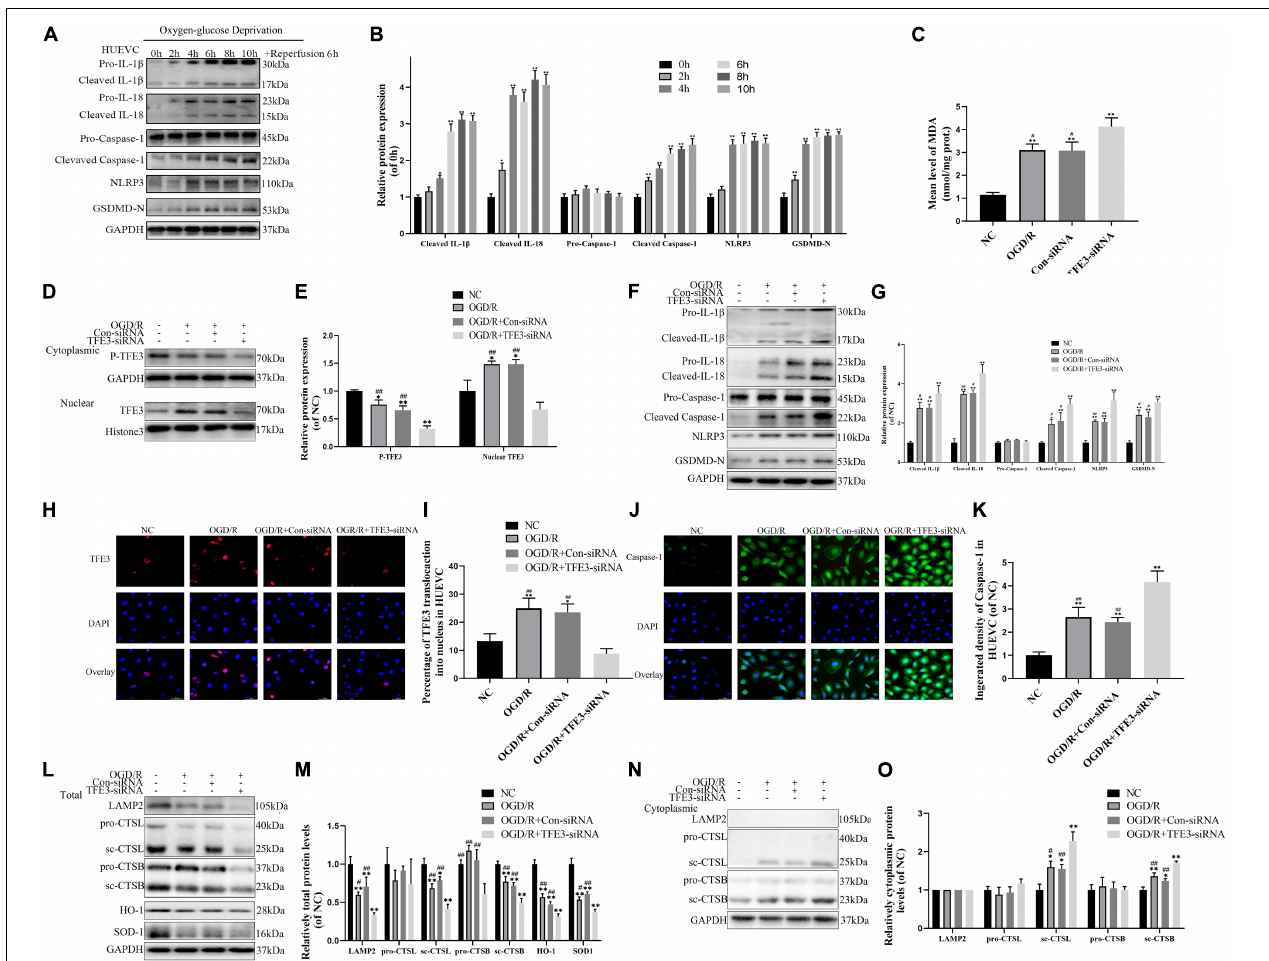
FIGURE 6 | TFE3 silencing aggravates lysosomal malfunction and promotes pyroptosis in the OGD/R cell model. (A) Western blotting of the pyroptosis markers in HUVECs. (B) Quantification of pyroptosis related proteins immunoblots in HUVECs. (C) ELISA of the oxidation product MDA in HUVECs from NC, OGD/R, OGD/R + Con-siRNA, and OGD/R + TFE3-siRNA groups. (D) Western blotting of the level of cytoplasmic and nuclear TFE3 in HUVECs. (E) Quantification of TFE3 immunoblots. (F) The protein levels of pyroptosis related proteins in HUVECs from each group were detected via western blotting. (G) Quantification of pyroptosis related proteins. (H) Immunofluorescence was performed to exhibit the nuclear translocation of TFE3 (red) in the HUVECs (scale bar: 25 mm). (I) Percentage of TFE3-positive cells. (J) Immunofluorescence to detect the caspase-1 expression level was conducted to exhibit the pyroptosis level in the HUVECs (scale bar: 25 mm). (K) The fluorescence intensity of caspase-1 analyzed using ImageJ. (L,N) Western blotting of LAMP2, CTSL, CTSB, SOD1, and HO-1 in HUVECs from each group. (M,O) Western blot and its quantification showed the level of LAMP2, CTSL, CTSB, SOD1, and HO-1. Data are the mean ± SEM, n = 6 per group. * p < 0.05 and ** p < 0.01, vs. NC group. # p < 0.05 and ## p < 0.01, vs. OGD/R + TFE3-siRNA